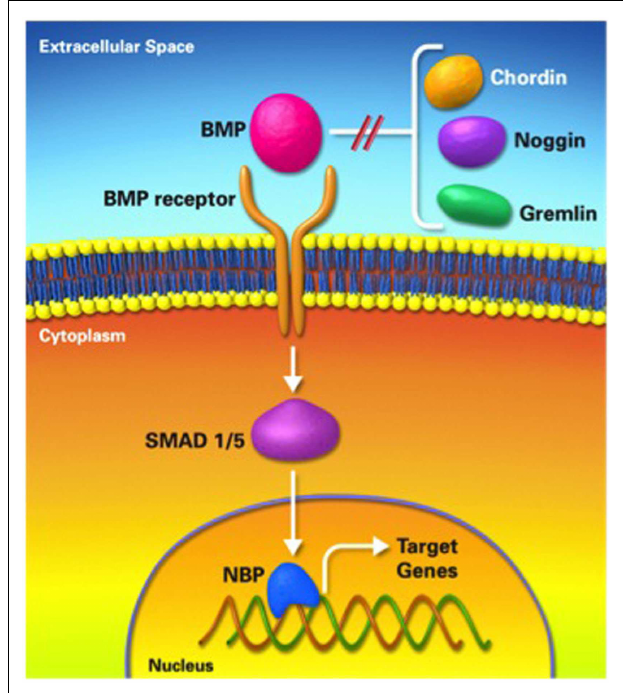
FIGURE 6 | Bone morphogenic protein pathway . BMP; bone morphogenic protein, NBP; nuclear binding